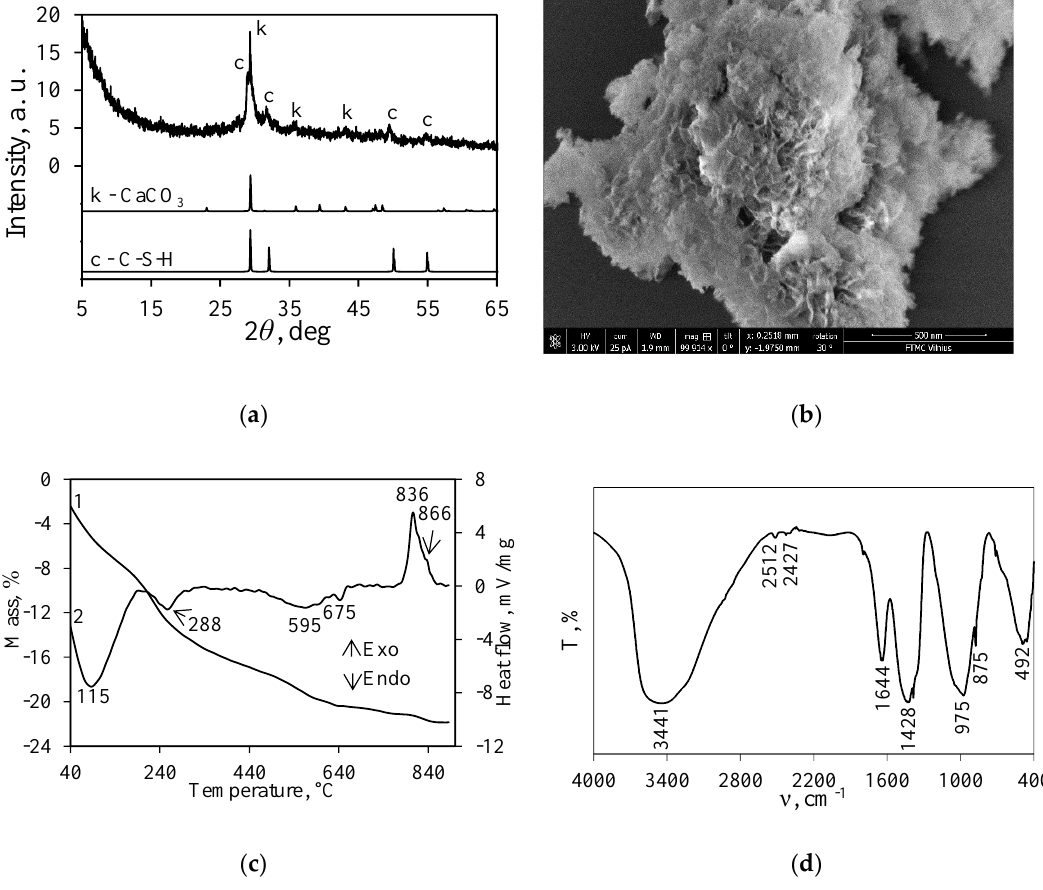
Figure 1. XRD pattern ( a ), SEM image ( b ), STA curves (curve 1 — TG; curve 2 — DSC) ( c ), and FT-IR spectrum ( d ) of the synthesis products. Indexes: k – calcite, c – C-S-H(I)/C-S-H(II).